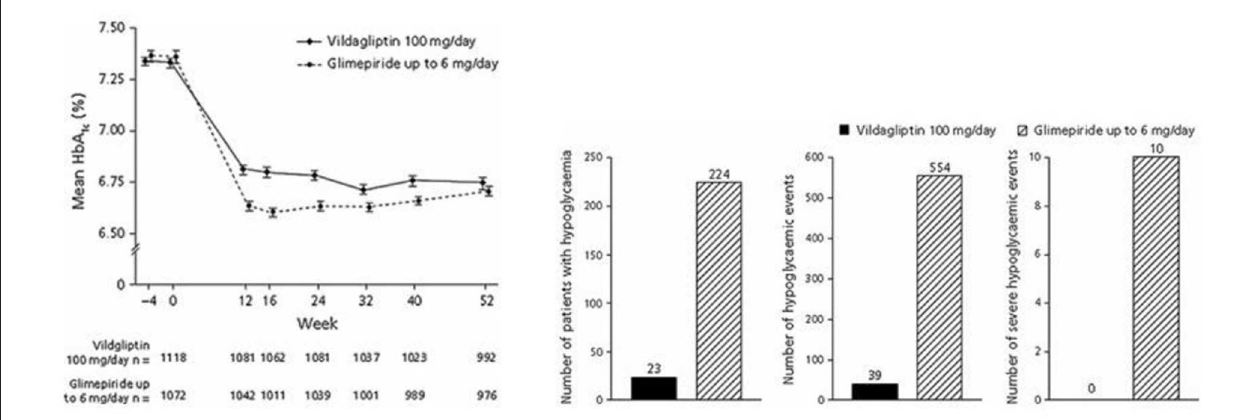
FIGURE 9 | Mean HbA 1c , number of patients with hypoglycemia, number of hypoglycemic events and number of severe hypoglycemia events during treatment with the DPP-4 inhibitor vildagliptin plus metformin or the sulfonylurea glimepiride plus metformin in subjects with type 2 diabetes. Means ± S.E.M. are shown. Data from Ferrannini et al. (103). Reprinted with permission from